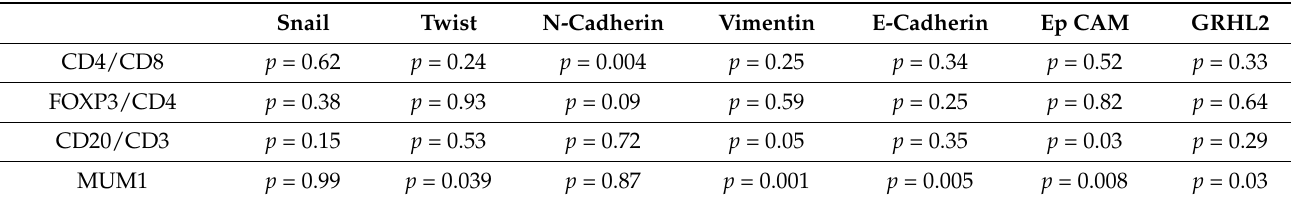
Table 7. Association between the EMT-related markers and the immune cell populations which constitute the inflammatory infiltrate of the